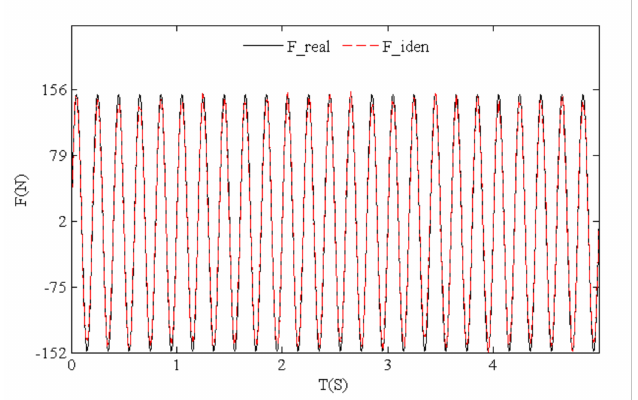
Figure 15. Time history of identified and real values for test harmonic loads.